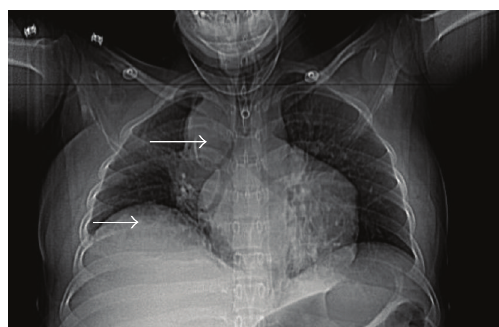
Figure 1: Chest X-ray. Right paratracheal soft tissue opacity mea- suring approximately 4 × 4cm. Elevation of the right hemidi- aphragm with a linear density in the right lower lung consistent with